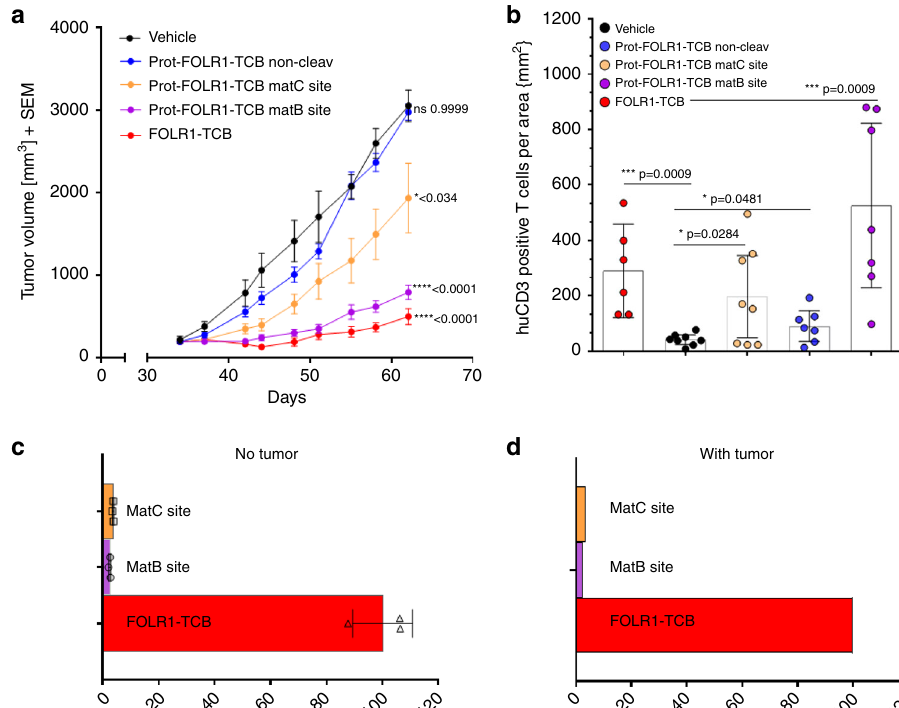
Fig. 9 Prot-FOLR1-TCB is ef fi cacious in vivo while there is no hint for tumor-leakage of activated Prot-FOLR1-TCB. a Tumor growth inhibition curves of breast PDX BC004 model in humanized mice. Humanized mice ( n = 9 per group) were weekly i.v. injected with equimolar doses of Prot-FOLR1-TCBs (4 mg/kg) containing different cleavage sites, FOLR1-TCB (3.6 mg/kg) or vehicle. Each dot represents the mean tumor volume ± SEM. Ef fi cacy was evaluated by measuring the reduction of the mean tumor volume at day 62 relative to vehicle control. Statistical analysis was done using one-way ANOVA with Tukey − Kramer correction. No signi fi cant ef fi cacy was observed for the Prot-FOLR1-TCB with the noncleavable linker comparing to vehicle control. Signi fi cant tumor growth inhibition was induced by the FOLR1-TCB (**** p < 0.0001), the Prot-FOLR1-TCB with the matB site (**** p < 0.0001) and the Prot- FOLR1-TCB with matC site (* p = 0.034) all compared to vehicle group. The in vivo ef fi cacy study has been conducted once ( n = 9 mice per group; n = 8 mice for matB group). b Quanti fi cation of human CD3-positive T cells for the different treatment groups of ef fi cacy study using breast PDX in humanized mice. All data points shown in bar chart. Each data point represents the value for one mouse. 95% con fi dence interval is shown for each group. Two-tailed, unpaired t test was used to calculate statistics. Signi fi cantly more huCD3 T cells per mm 3 were found for animals treated with FOLR1-TCB (*** p = 0.0009) and Prot-FOLR1-TCBs (matC * p = 0.0284 and matB site *** p = 0.0009) than for vehicle group. However also the Prot-FOLR1-TCB with a noncleavable linker had signi fi cant more huCD3 T cells per area compared to vehicle (* p = 0.0481). Representative images are shown in Supplementary Fig. 9. c , d Bioavailability of active Prot-FOLR1-TCBs with different linkers in non-tumor-bearing ( c ) and tumor-bearing humanized mice ( d ). Bioavailability of active Prot-FOLR1-TCB containing different cleavage sites at day 7 after injection in non-tumor-bearing humanized NSG mice ( n = 3 per group) or breast PDX tumor-bearing humanized mice ( n = 6 per group). Bioavailabilities F of the active FOLR1-TCB after Prot-FOLR1-TCB administration were calculated (as described in Fig. 8) by comparing AUC 0 − 168 h values of FOLR1-TCB following i.v. administration of the respective pro-TCB (AUC from Prot-FOLR1-TCB) and administration of the active TCB (AUC FOLR1-TCB) according to F (%) = (AUC from Prot-TCB/AUC TCB)× 100. For tumor-bearing mice AUC were calculated from composite concentration − time data ( n = 3/time point). Dose corrections were not required, as equimolar doses of Prot-FOLR1-TCB and FOLR1-TCB were used in the respective